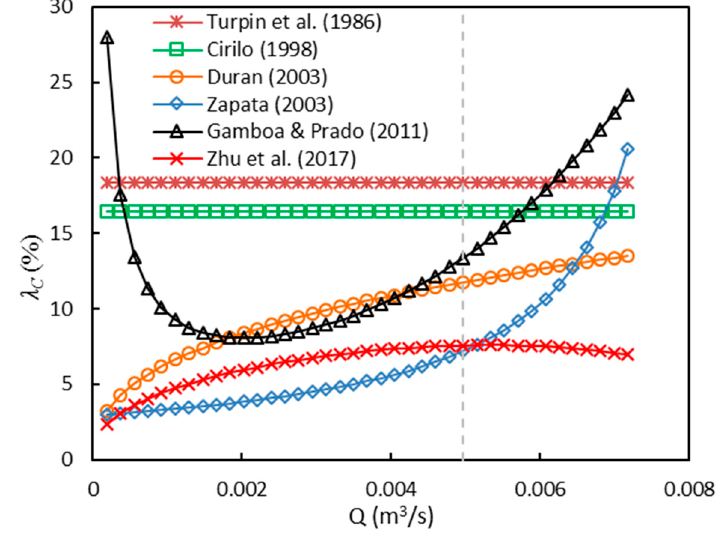
Figure 17. Comparison of surging initiation models for ESP gas/liquid flow [122].